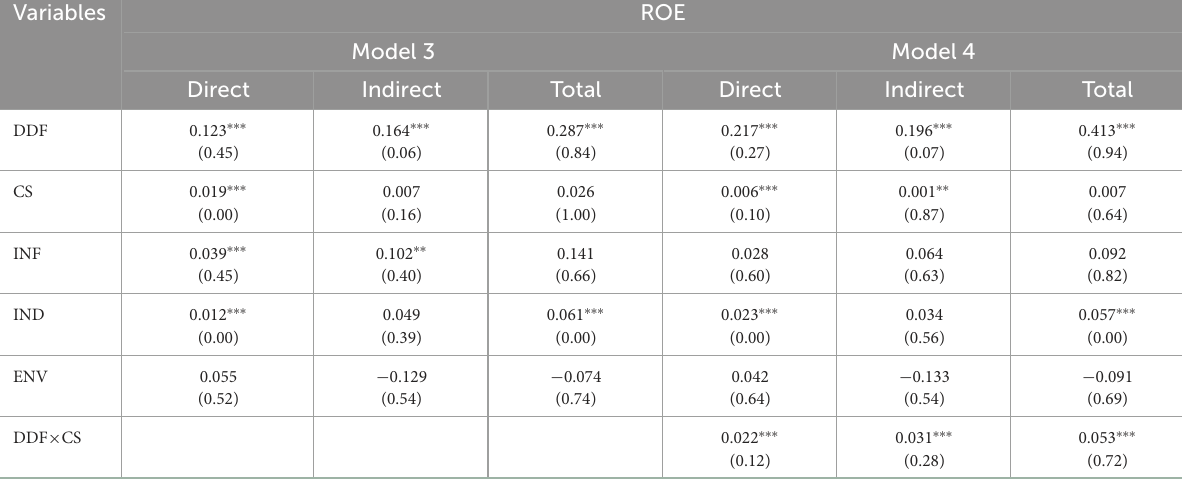
TABLE 7 Decomposition of spatial spillover effects.